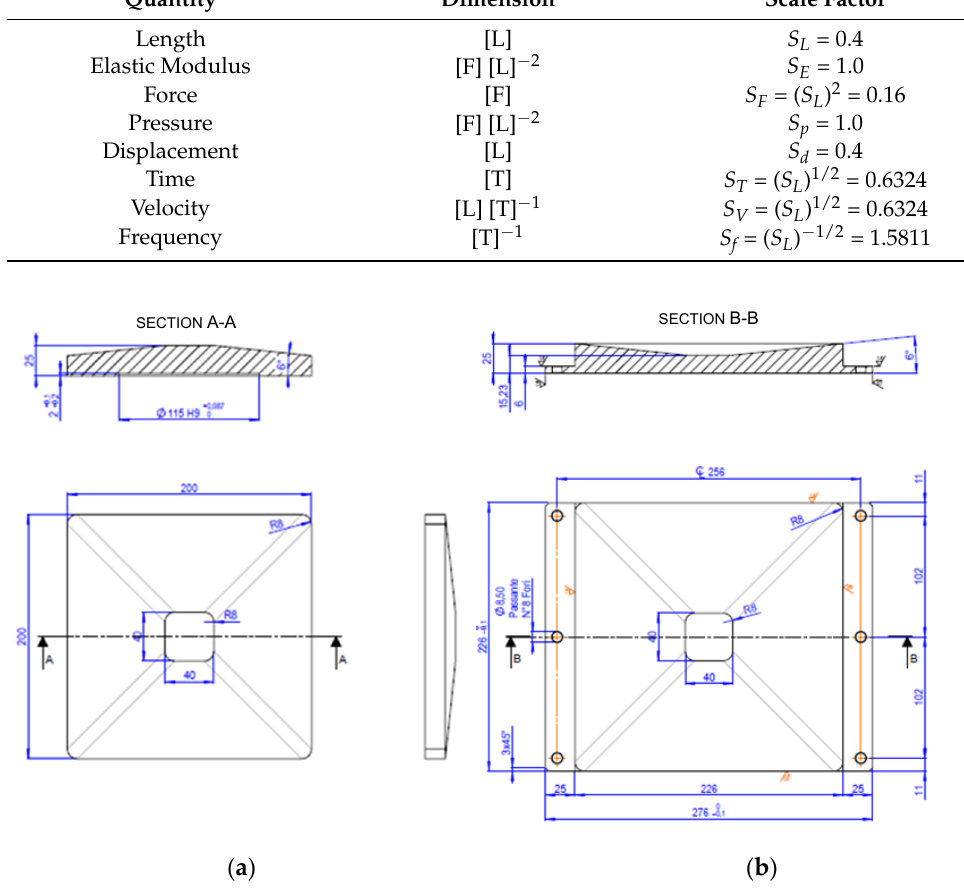
Figure 4. Small scale prototype of the DCS: ( a ) convex plate; ( b ) concave plate. Units in